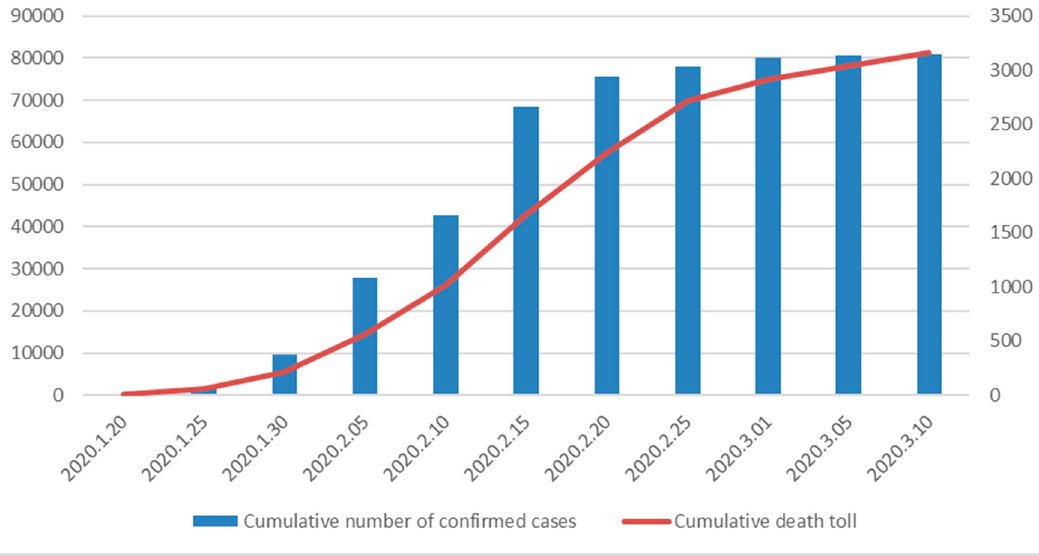
Figure 1. The trend of COVID-2019 in the Hubei province of China.